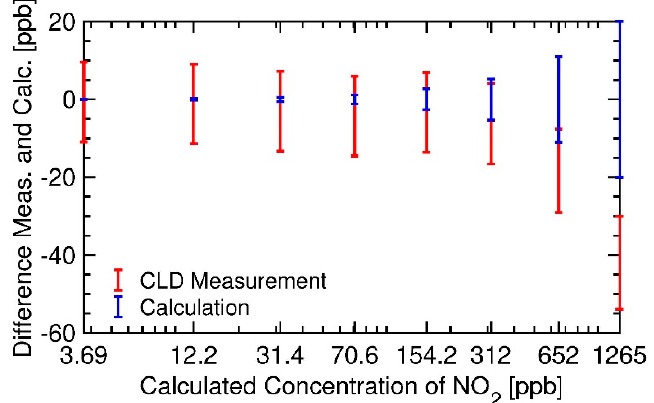
Figure 2. Deviation of the measured from the calculated concentrations ( x -axis). Calculated (blue) and measured (red) values are shown with corresponding error bars and are baseline corrected to